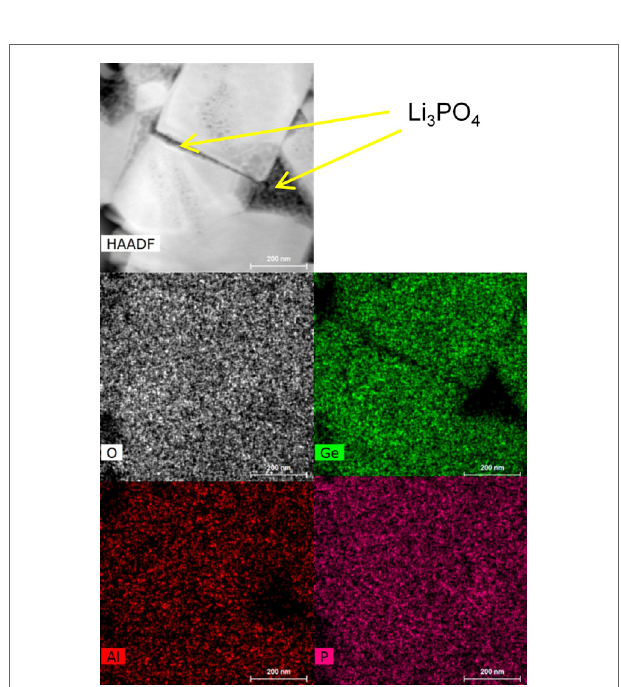
FigUre 7 | X-ray diffraction patterns for hF (top) and conventionally (bottom) sintered lagP .